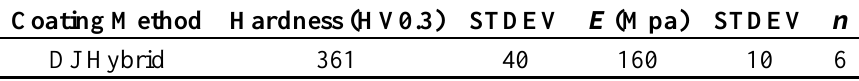
Figure 7. Optical micrograph of a cross-section of HVOF DJ Hybrid sprayed FeNiCrAl coating before testing. Table 4. Indentation results for the HVOF thermal spray coating.